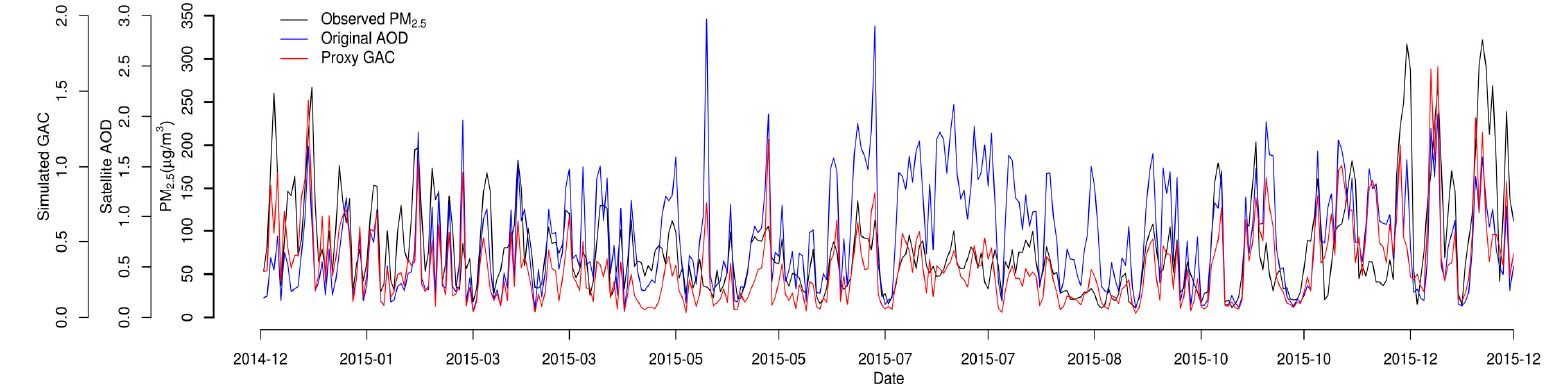
ff erentiation (AD).